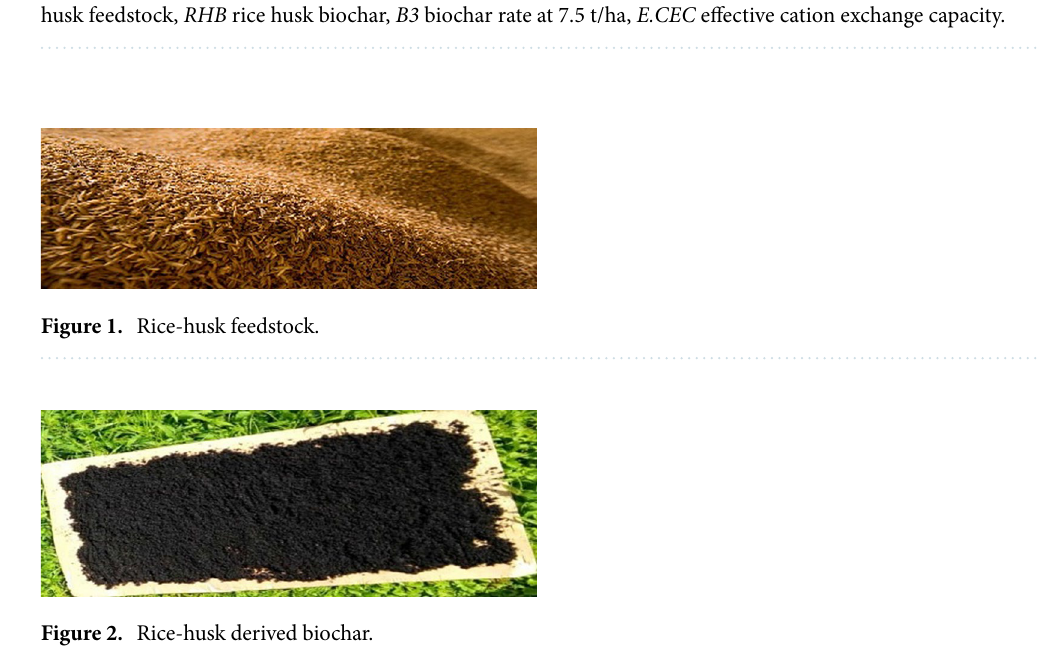
Table 1. The physicochemical properties of the soil before and after biochar amendment; chemical properties of rice husk feedstock and biochar. BBA before biochar amendment, ABA after biochar amendment, RHF rice